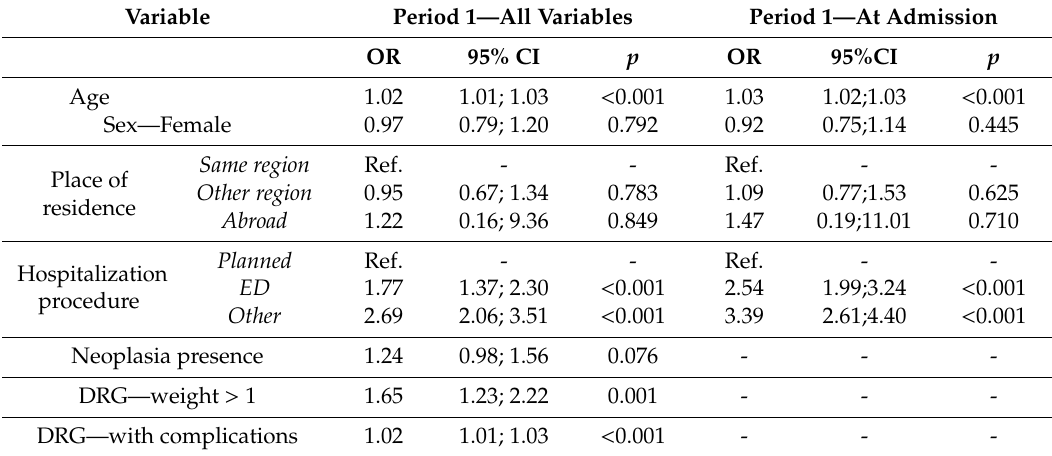
Table 3. Discharge destination outcomes—logistic regression